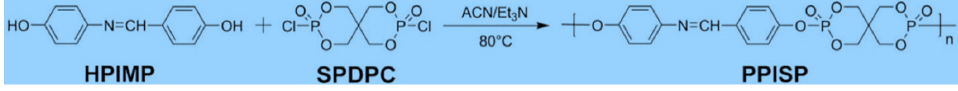
Figure 10. Synthetic route for PPISP.